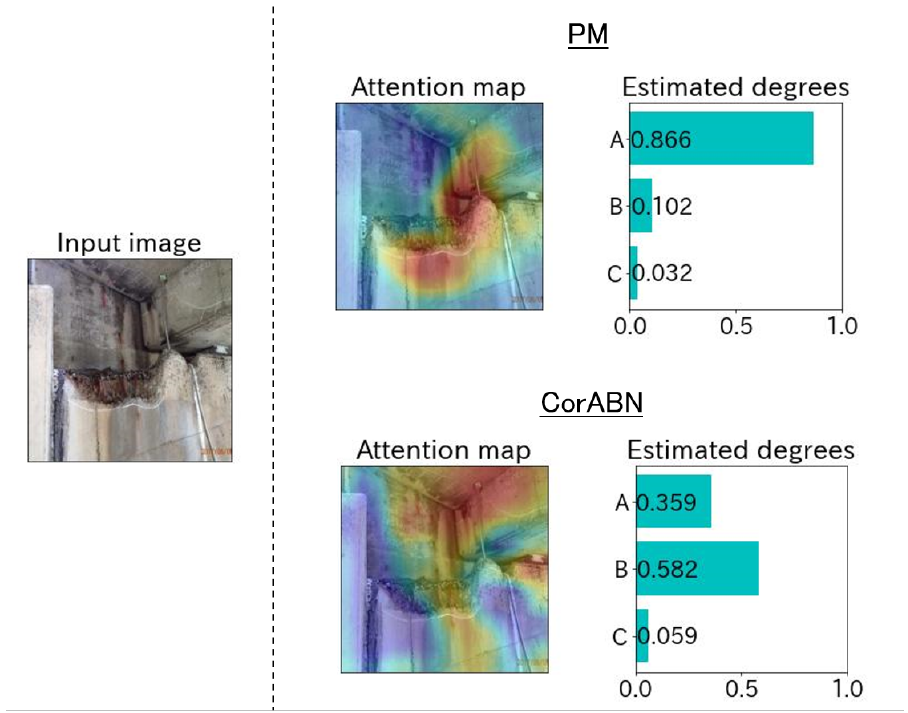
Figure 7. Estimated example at the degradation degree A for the distress type of concrete